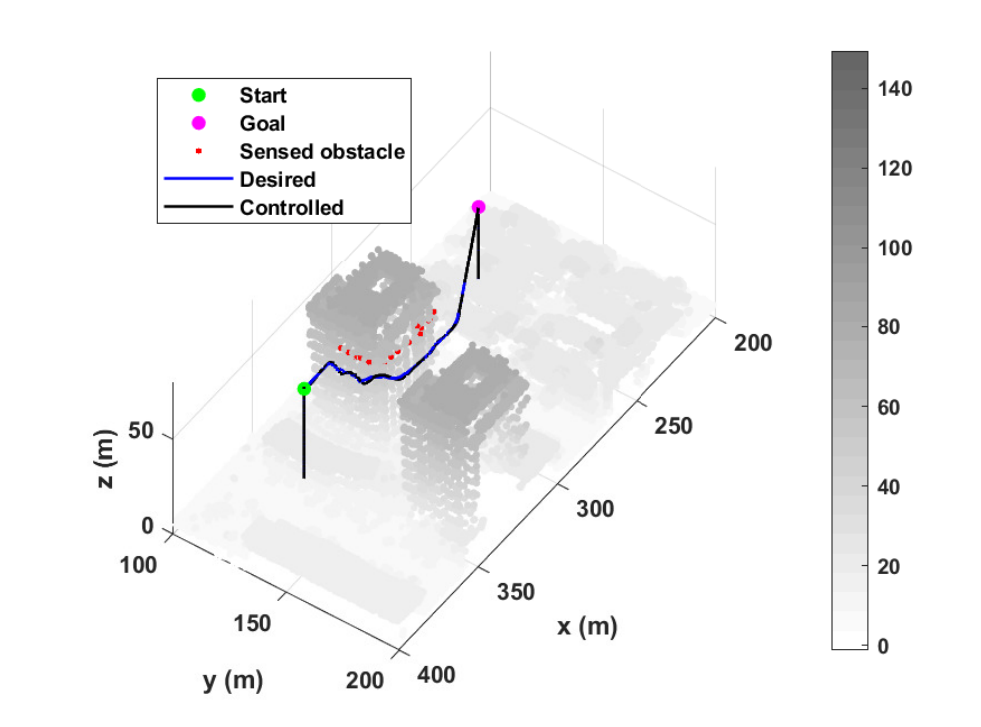
Figure 9. Case 1: Quadcopter’s trajectory.